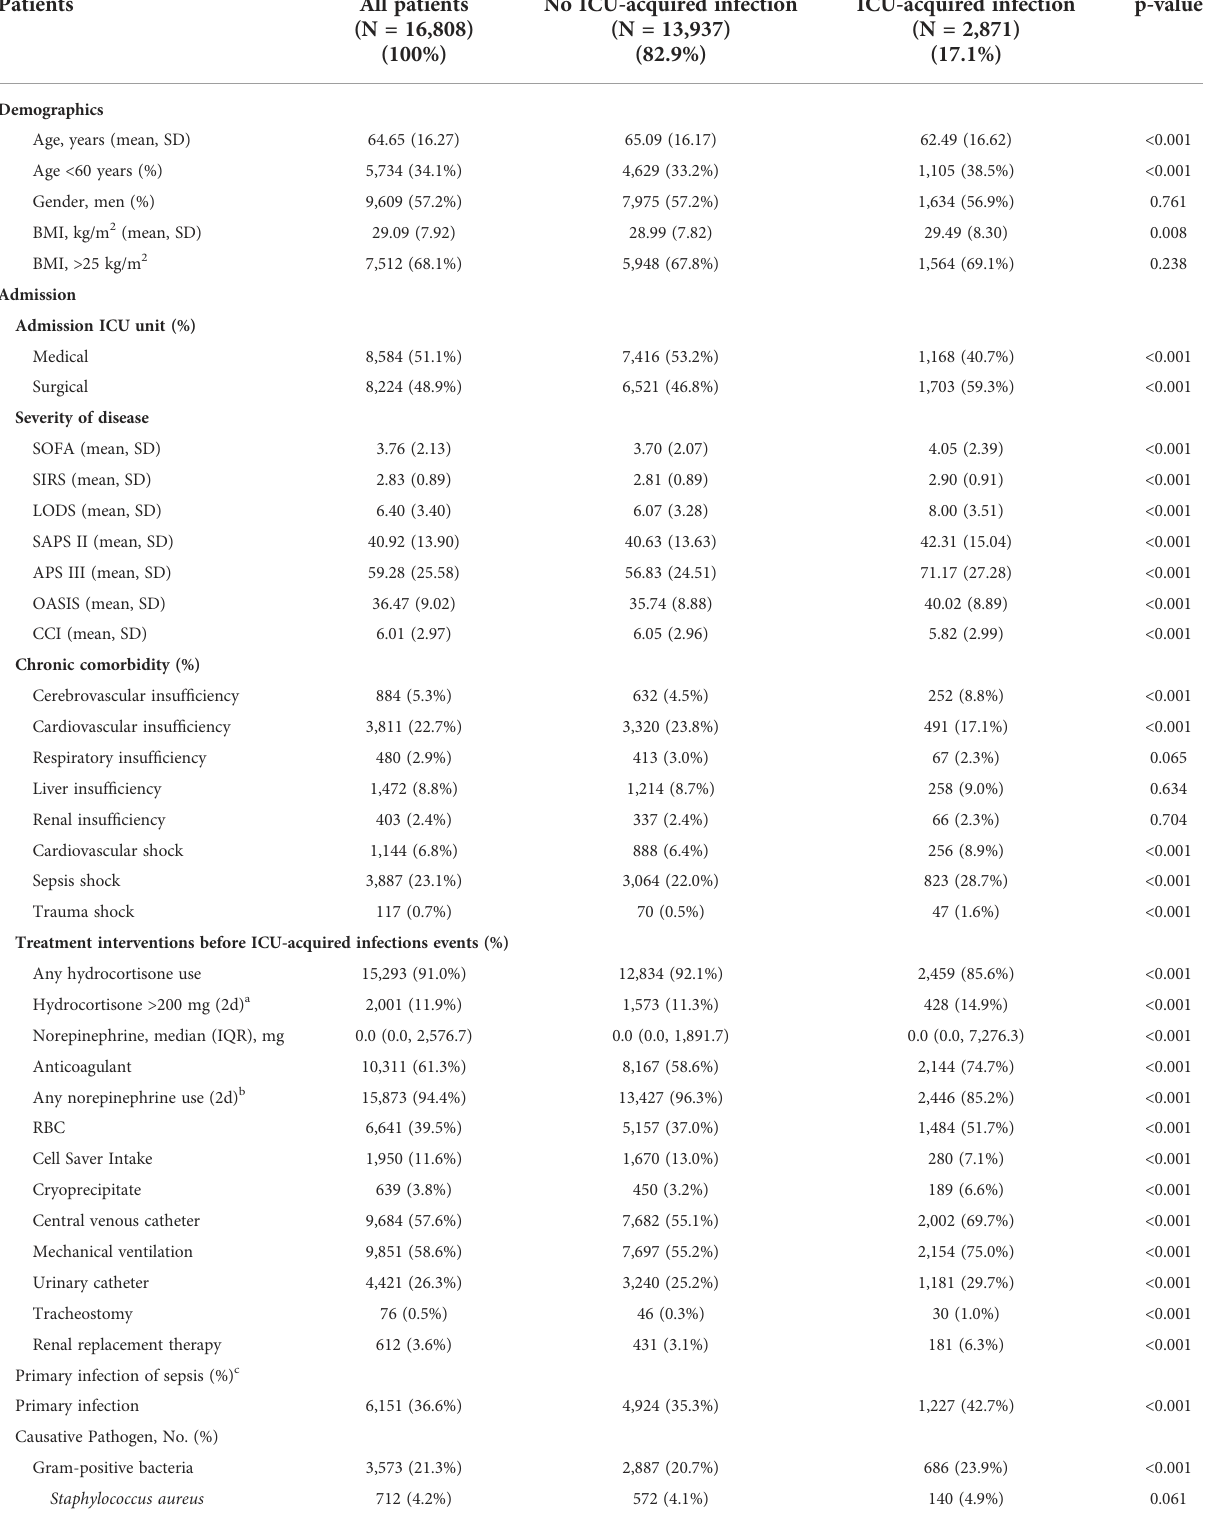
TABLE 1 Baseline characteristics and outcomes of sepsis strati fi ed according to the development or not of ICU-acquired infection.